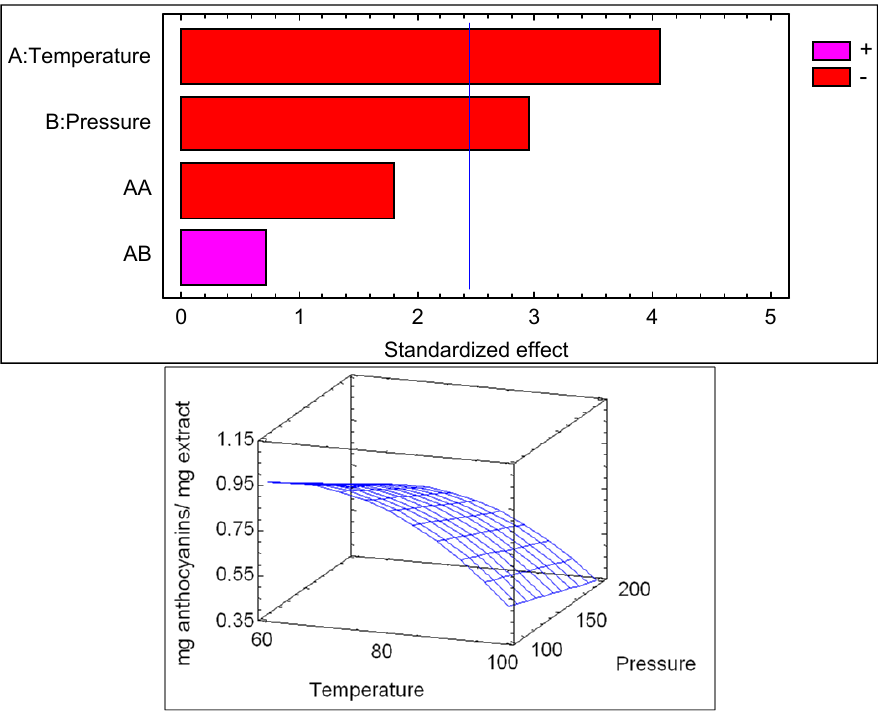
Figure 6. Pareto diagram and response surface for the PLE of anthocyanins with respect to extraction temperatures and